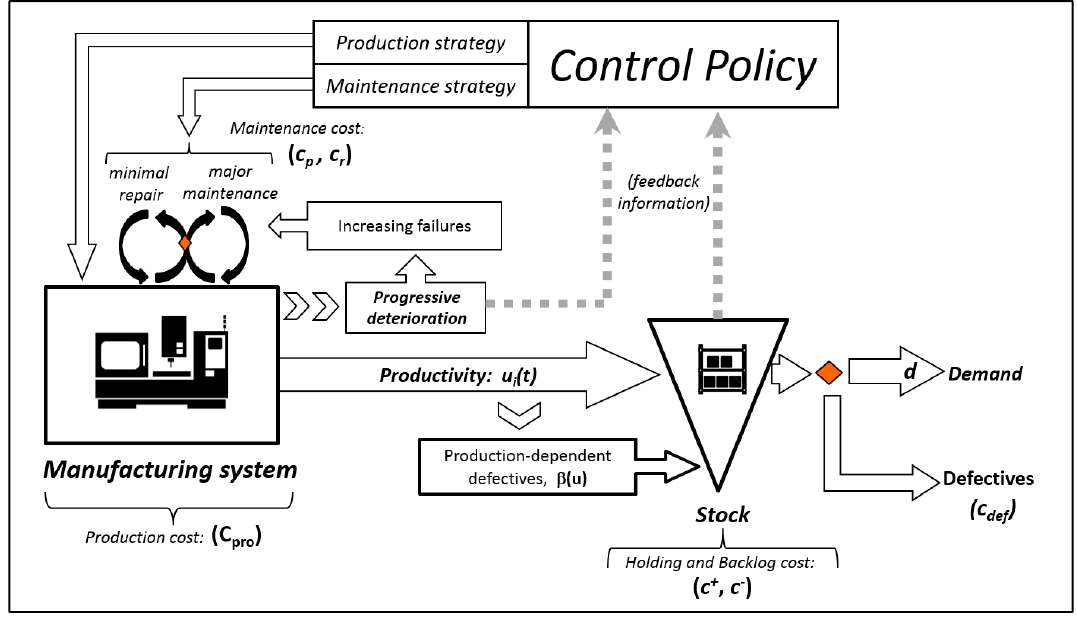
Figure 1. Manufacturing system under study.